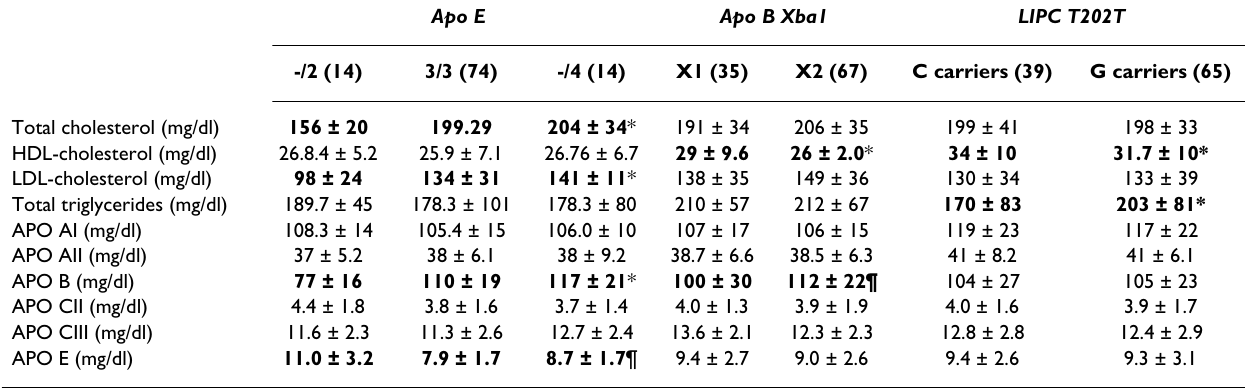
Table 3: Comparison of plasma lipids and apoproteins levels according to alleles in CAD subjects (n. 102)